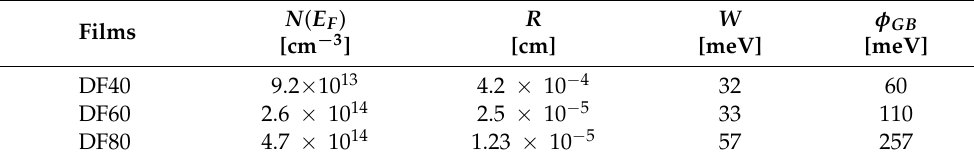
Table 3. The calculated parameters of the M-VRH